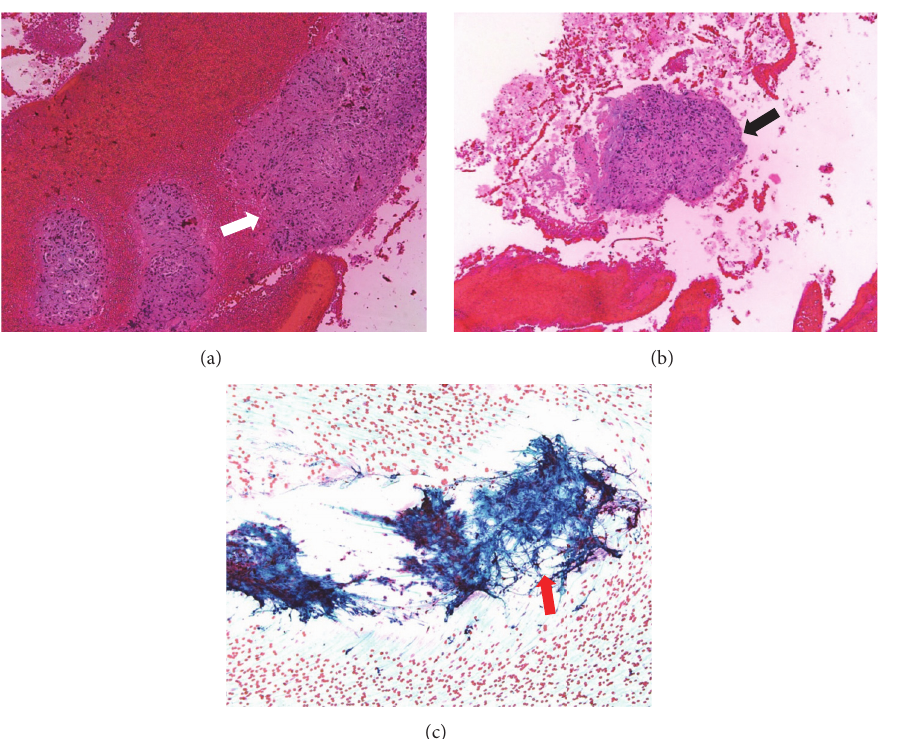
Figure 3: (a) Hematoxylin and eosin stain, 20x magnification, cell block, epithelioid, and noncaseating granuloma in a background of blood (white arrow). (b) Pancreatic mass fine needle aspiration, Papanicolaou stain, 20x magnification, and cell block, showing small fragments of epithelioid, noncaseating granuloma (black arrow). (c) Pancreatic mass fine needle aspiration, Papanicolaou stain, 40x magnification, smear showing epithelioid, and noncaseating granuloma (red